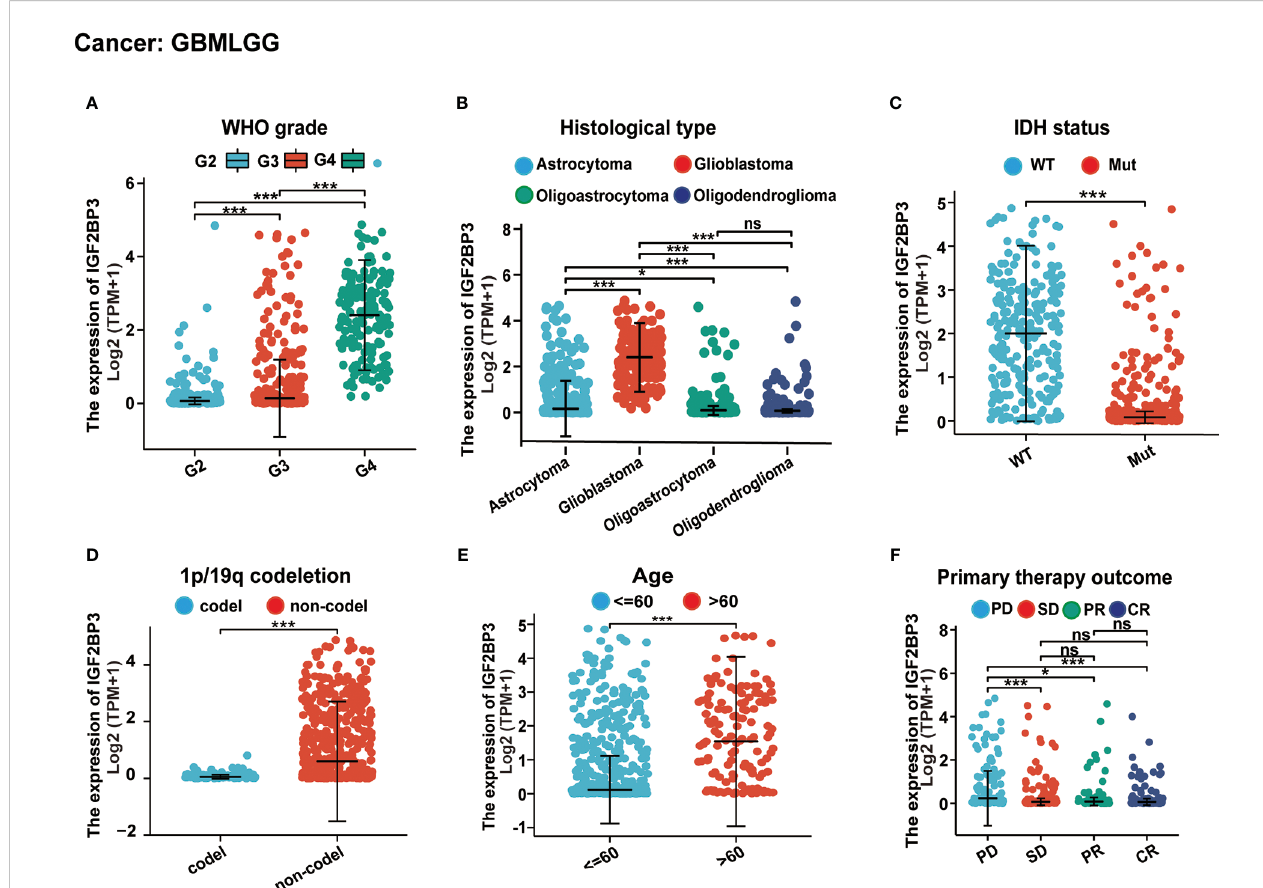
FIGURE 3 Associations between IGF2BP3 expression and different clinical characteristics in GBMLGG. (A) WHO grade; (B) Histological type; (C) IDH status; (D) p/ 19q codeletion; (E) Age; (F) Primary therapy outcome. ns, p ≥ 0.05; *p < 0.05; ***p <